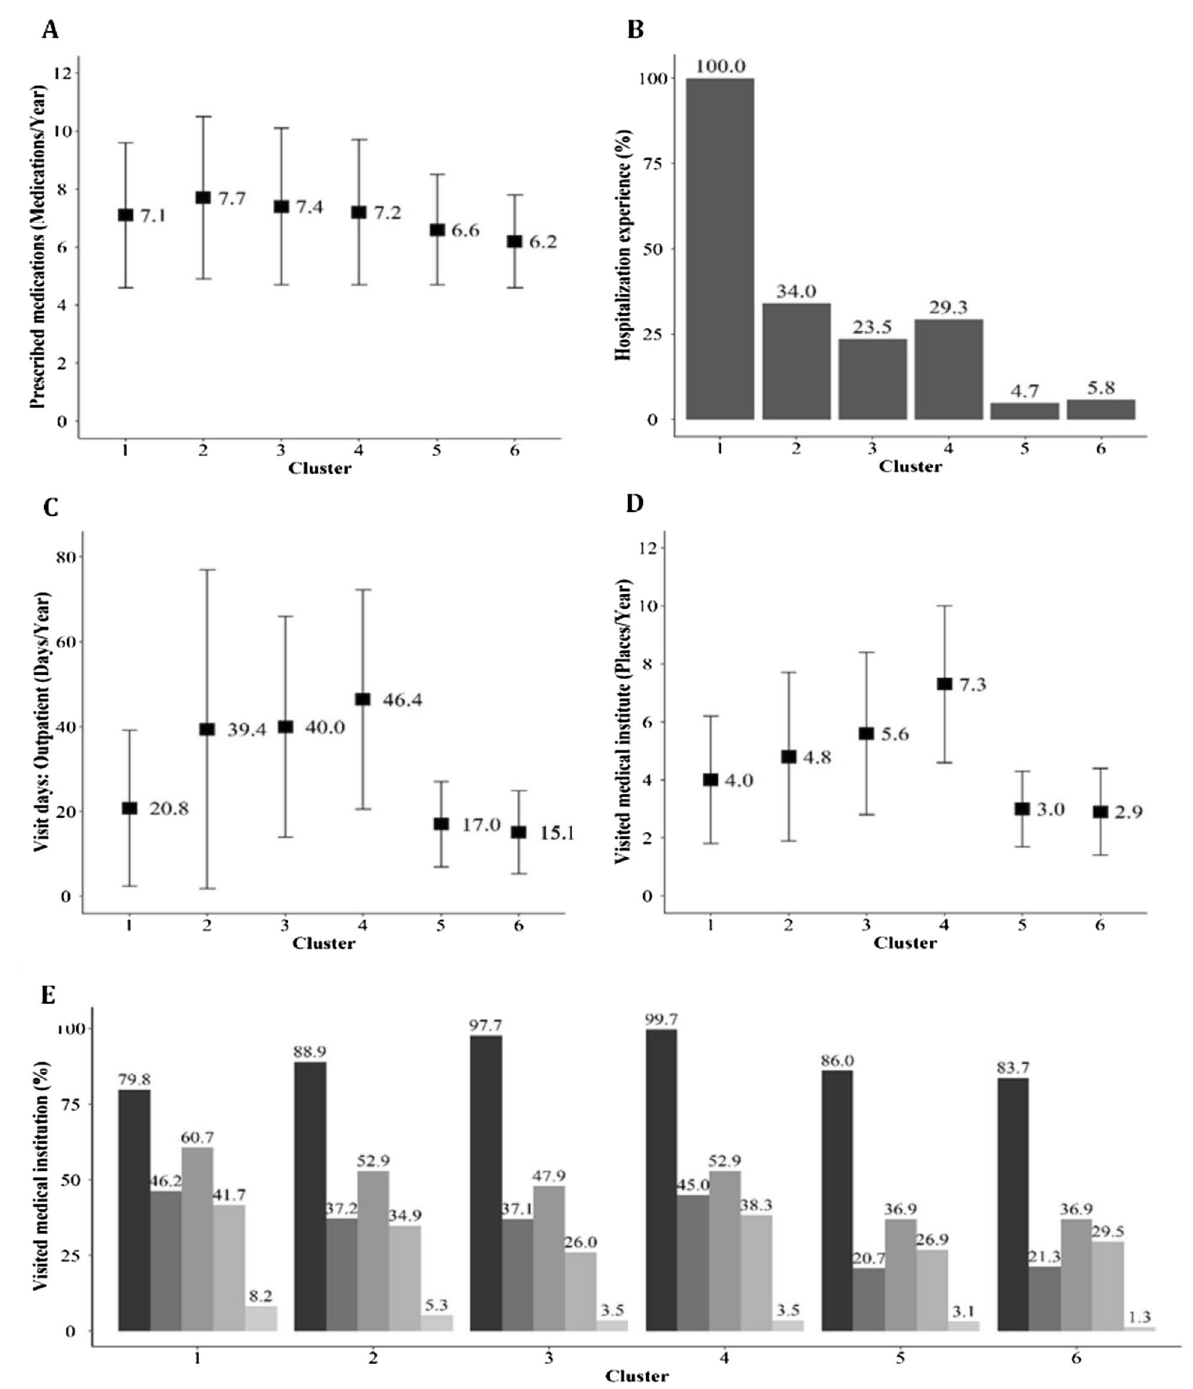
Figure 2. Comparison of health care utilization in six clusters of study patients with polypharmacy. Categorical variables were evaluated by chi-square test and continuous variables by t-test to compare the characteristics of each cluster. The following attributes are described by cluster: ( A ) the number of prescribed medications per year; ( B ) hospitalization experience; ( C ) the number of outpatients visit days per year; ( D ) the number of medical institutes visited by patients per year; and ( E ) medical institution type visited by patients (all P <